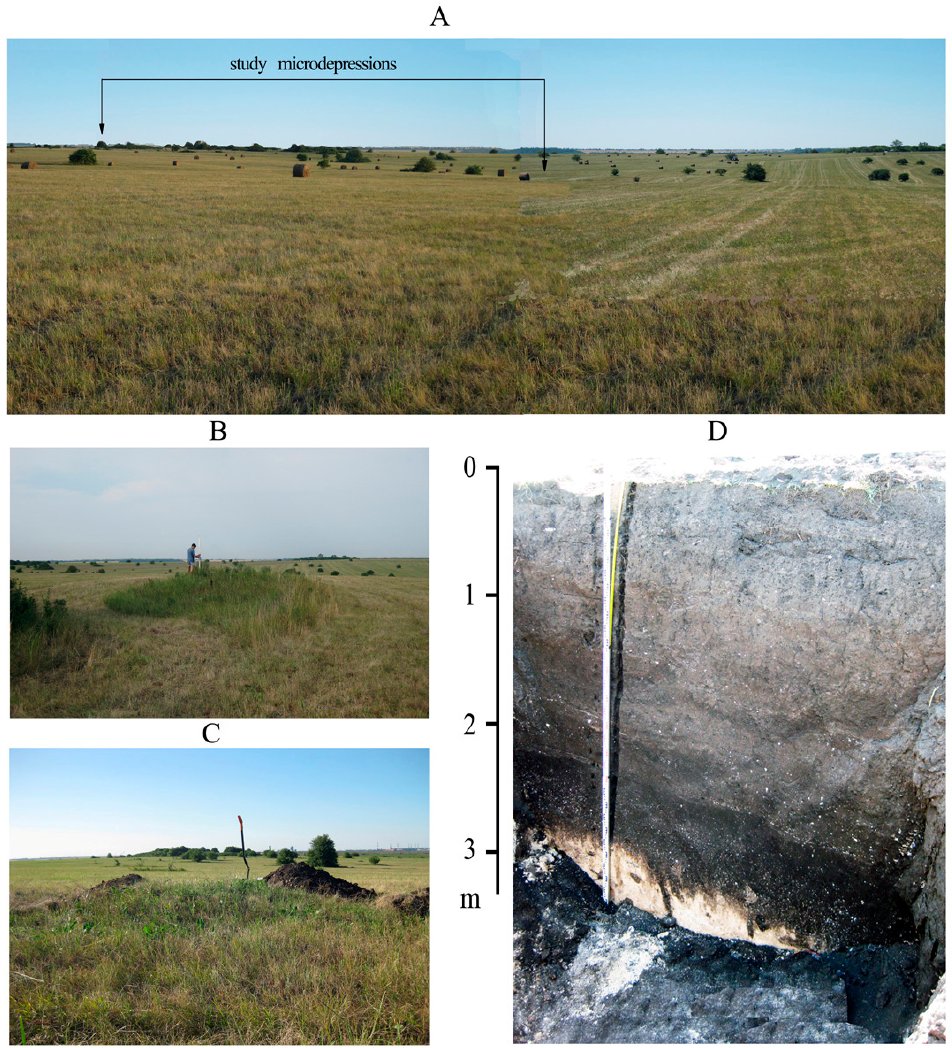
Figure 2. Study objects: ( A ) Closed depressions within the watershed plateau, ( B ) Burial mound of the Bronze Age; ( C ) Marmot mound; ( D ) Colluvial fan and immature paleosols at the base of the “Vishnyaki” gully.